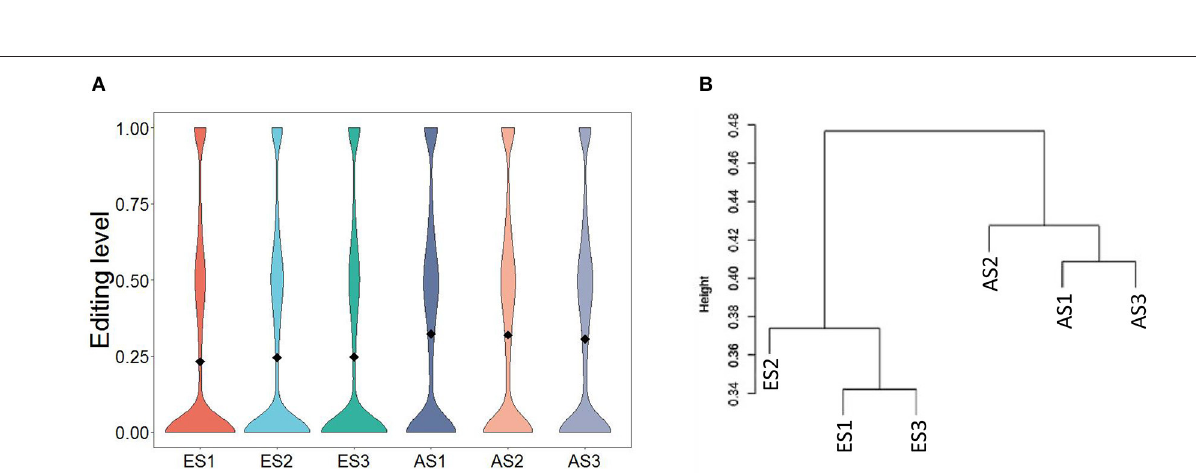
FIGURE 4 | Characteristics of RNA editing levels within and between groups. (A) Distribution of editing levels across samples; (B) Hierarchical clustering of RNA editing levels across